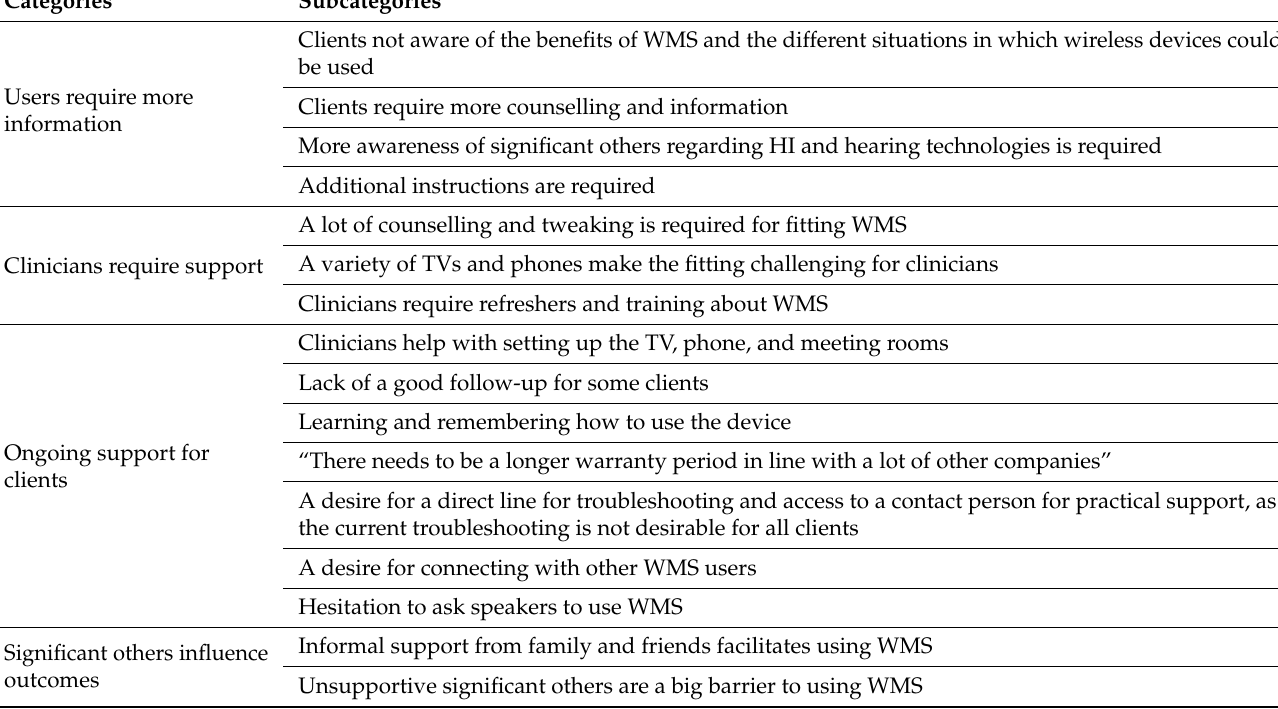
Table 6. Theme 5. Users require ongoing training and support to use wireless microphone